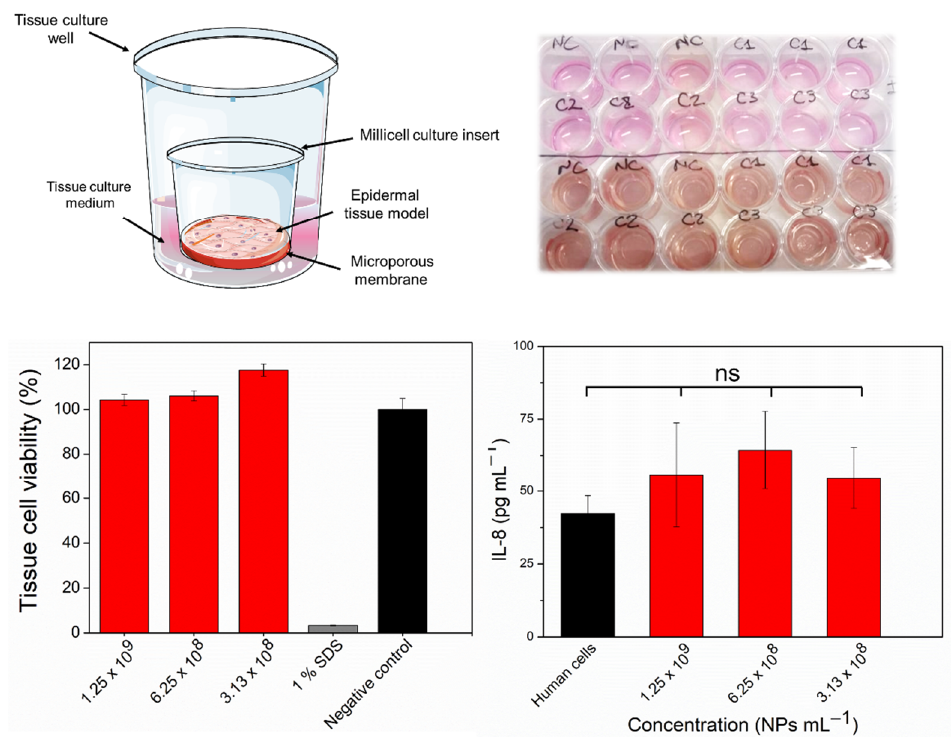
Figure 7. In vitro irritation test using an EpiDerm TM 3D skin model, treated with different concentrations of FSL NP during 18 h exposure. All data are mean values of three independent experiments; ns—statistically not significantly different ( p > 0.05).